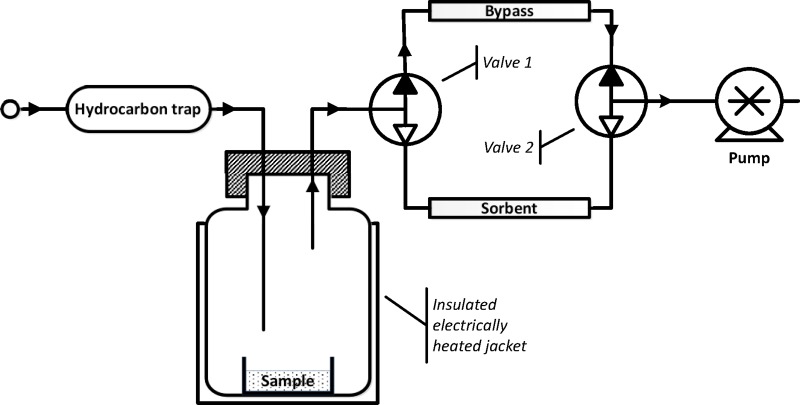
Apparatus for sampling faecal volatiles onto thermal desorption (TD) tubes.The sample is placed in a temperature-controlled bottle under a constant flow of air from which hydrocarbons have been trapped. After equilibration, airflow is diverted through a TD tube which retains volatile organic compounds emitted by the sample and which is then removed for subsequent laboratory analysis.